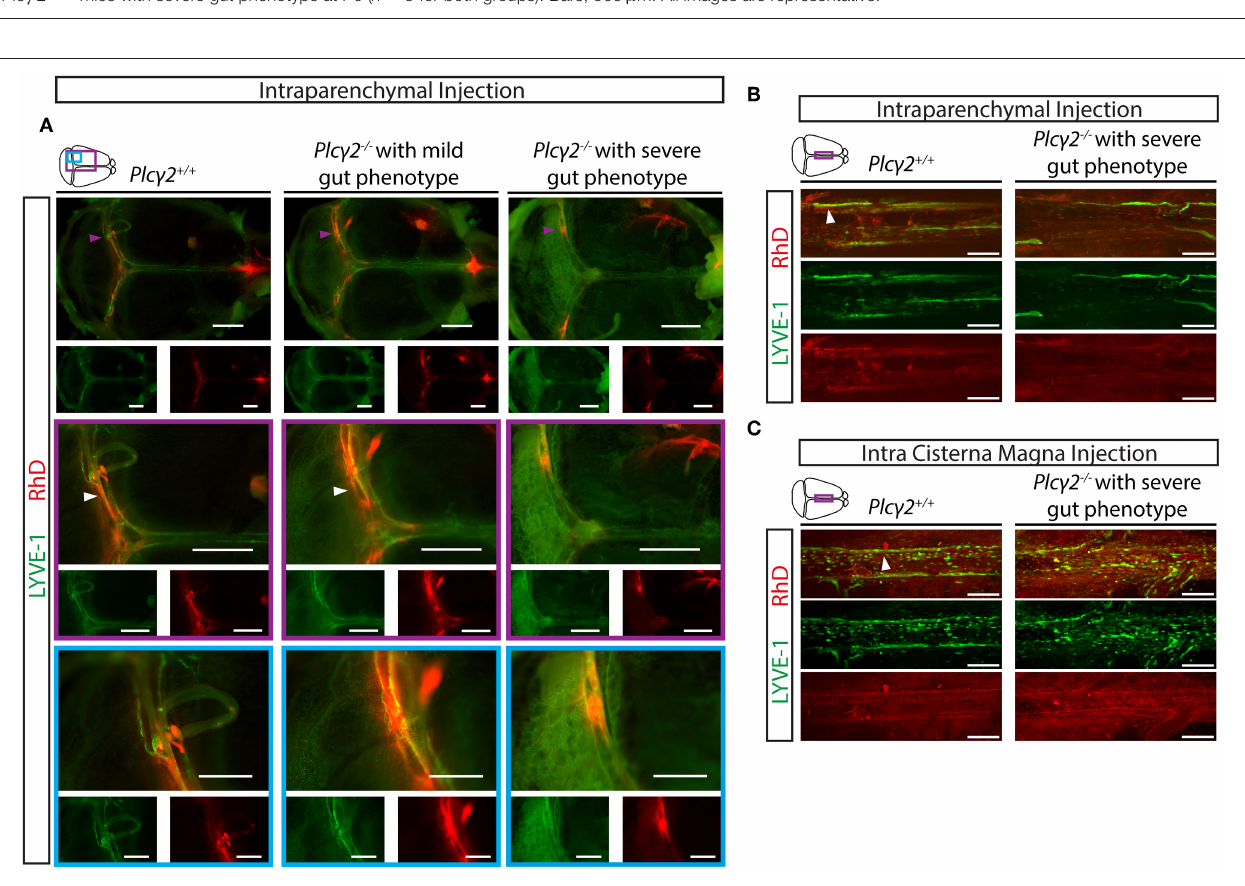
FIGURE 9 | Uptake and transport of labeled macromolecules by the meningeal lymphatics in Plc γ 2 + / + and Plc γ 2 − / − mice. (A) Uptake and transport of 70 kDa RhD by the meningeal lymphatic vessels after intraparenchymal injection of young adult Plc γ 2 + / + , Plc γ 2 − / − mice displaying mild or severe gut phenotype. Representative images are shown of whole-mount anti-LYVE-1 immunostaining of meninges of young adult mice ( n = 8 for Plc γ 2 + / + mice; n = 3 for Plc γ 2 − / − mice showing mild gut phenotype, n = 5 for Plc γ 2 − / − mice displaying severe gut phenotype). Purple arrowheads point to spots with a high intensity for macromolecule uptake, white arrowheads show meningeal lymphatic vessels draining RhD. Bars, 1,000 µ m. (B,C) Confocal images are shown of region adjacent to the superior sagittal sinus of whole-mount immunostained meninges of young adult Plc γ 2 + / + and Plc γ 2 − / − mice after intraparenchymal (B) or intra cisterna magna (C) injection of 70 kDa RhD (intraparenchymal injection: n = 3 for Plc γ 2 + / + mice; n = 3 for Plc γ 2 − / − mice displaying severe gut phenotype; intra cisterna magna injection: n = 3 for Plc γ 2 + / + mice; n = 2 for Plc γ 2 − / − mice displaying severe gut phenotype). White arrowheads show meningeal lymphatic vessels draining RhD. Bars, 200 µ